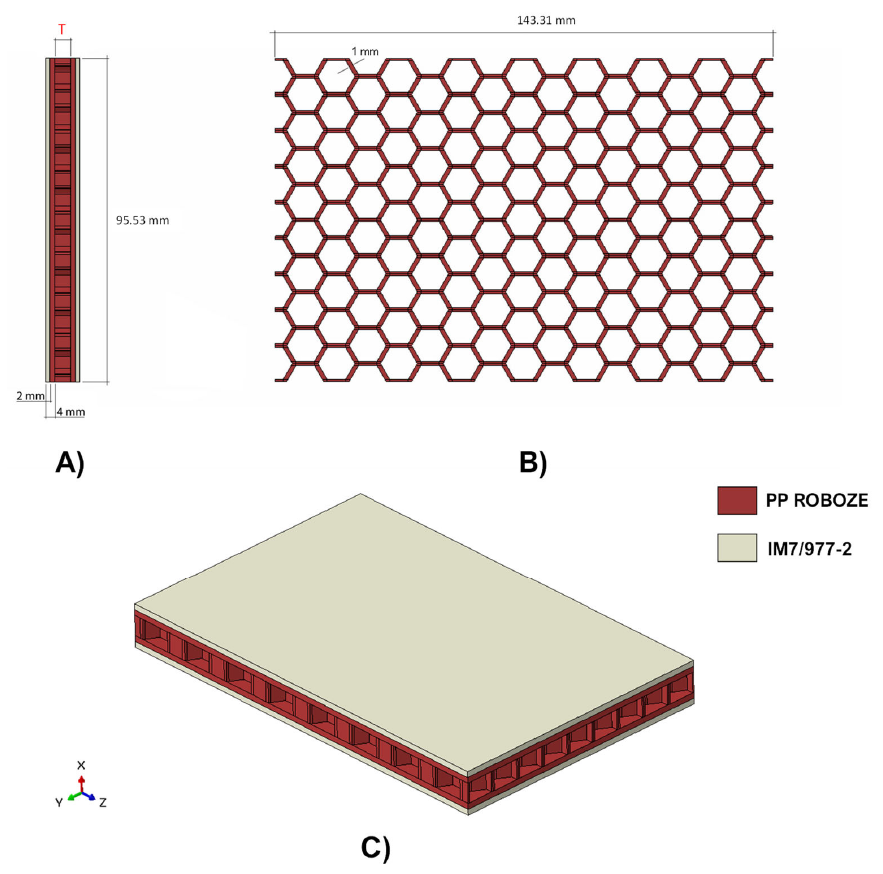
Figure 3. Geometrical details of the shock absorber. ( A ) lateral view, ( B ) top view, and ( C ) isometric view.